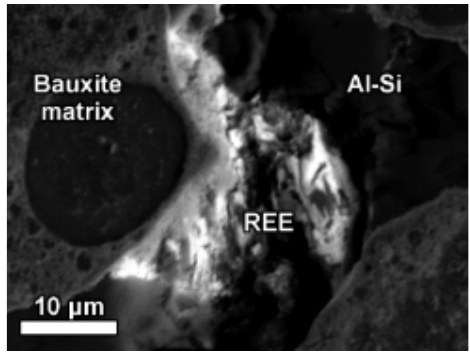
Figure 2 . REE phase in Parnassos-Ghiona bauxite associated with aluminosilicate (Al-Si).